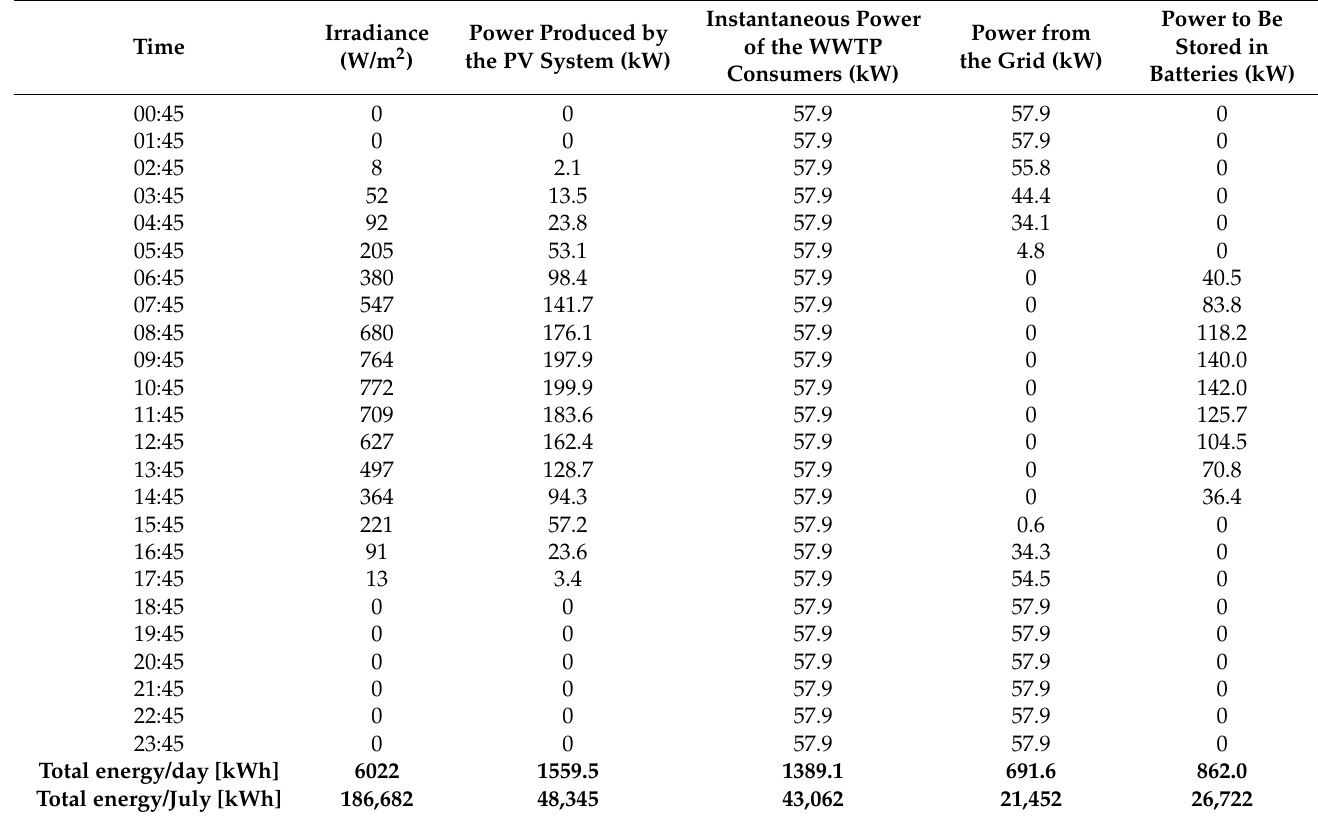
Table 4. Calculation for energy produced, required from the power grid and required to be stored, for one day and for month of